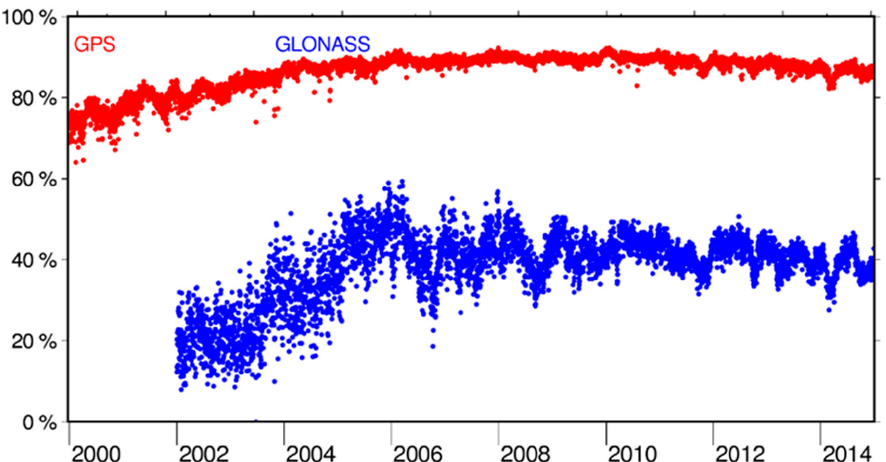
Figure 1. Success rate of the ambiguity resolution for Globalnaya Navigatsionnaya Sputnikovaya Sistema (GLONASS) (blue color) and Global Positioning System (GPS) (red color) observations for the period 2000–2015.